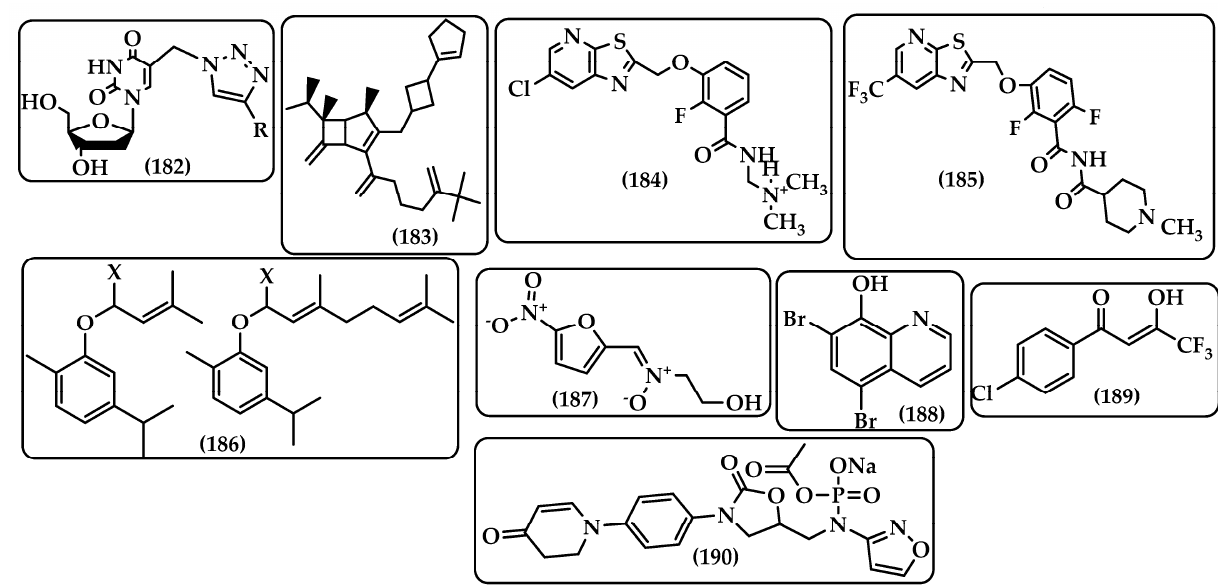
Figure 17. Chemical structure of WCK 5153 ( 168 ), ANT3310 ( 169 ), avibactam ( 170 ), relebactam ( 171 ), nacubactam ( 172 ), zidebactam ( 173 ), β -Lactamase-Activated Ciprofloxacin Prodrug ( 174 ), azithromycin prodrug (CSY5669) ( 175 ), tedizolid phosphate (TR701) ( 176 ), pretomanid ( 177 ), ceftaroline fosamil ( 178 ), C3D ( 179 ), DEA-C3D ( 180 ), triclosan glycoside prodrugs ( 181 ), prodrugs of 5-modified 2 (cid:48) -deoxyuridines ( 182 ), tebipenem pivoxil HBr salt ( 183 ), TXY436 ( 184 ), TXA709 ( 185 ), carvacrol prodrugs (WSCP18-19) ( 186 ), ADC111 ( 187 ), ADC112 ( 188 ), ADC113 ( 189 ), and contezolid acefosamil (CZA) prodrug ( 190